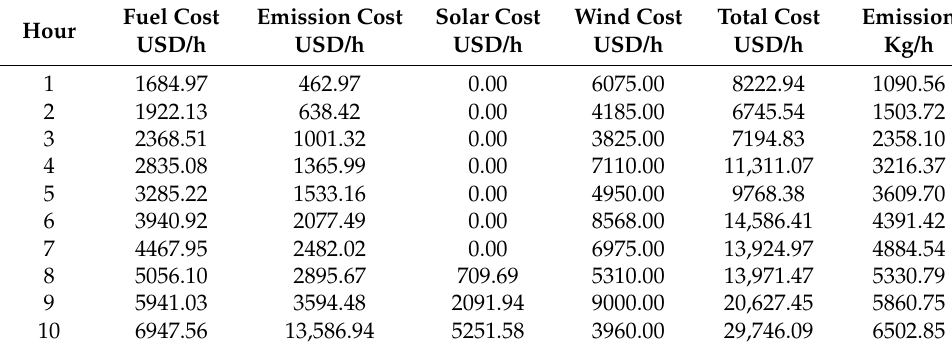
Table 27. Table of costs and emissions—case study